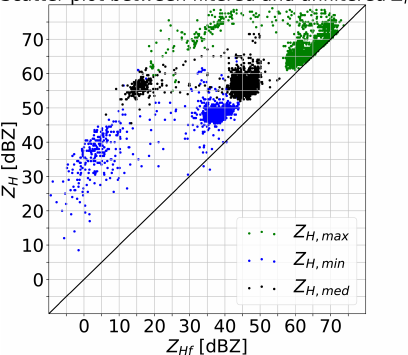
Figure 11. Scatterplot comparison of 10min moving minimum (blue), maximum (green) and median (black) Z Hf from Doppler- filtered (clutter notch of ± 3 . 5ms − 1 ) and unfiltered reflectivity data Z H